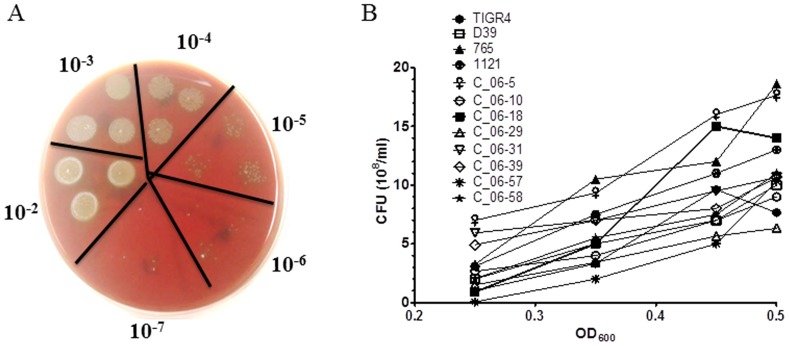
Calibration of a standard curves to quantify different strains of S. pneumoniae.
Twelve different strains of S. pneumoniae were grown in THY medium and CFUs quantified based on OD value over the mid-exponential phase of growth. (A) A representative blood agar plate showing the number of CFUs at 16 hr of incubation in a series of 10-fold diluted S. pneumoniae broth culture in triplicate is shown. (B) Calibration curves were plotted for each strain to quantify 12 different S. pneumoniae strains in CFUs per mL over the OD600 values from 0.2 and 0.6. Each data point on the graph represents the average value of two experiments.